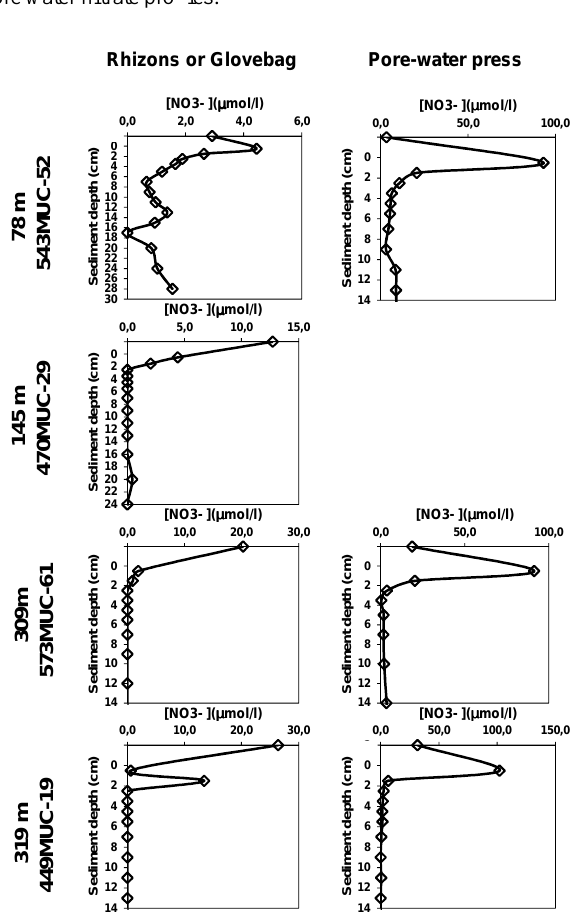
Fig. A2. Pore water nitrate profiles at different water depths along the Peruvian OMZ, including bottom water nitrate concentrations. Profiles on the left represent data from cores sampled with rhizons or in a glove bag. Profiles on the right represent data from cores sampled with a pore water press. Information about the sampling sites is shown in Table A2